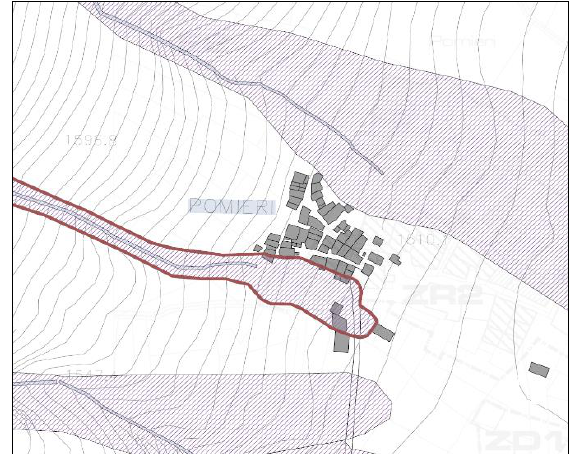
Figure 6. Map of the avalanche area of winter 2008-2009.